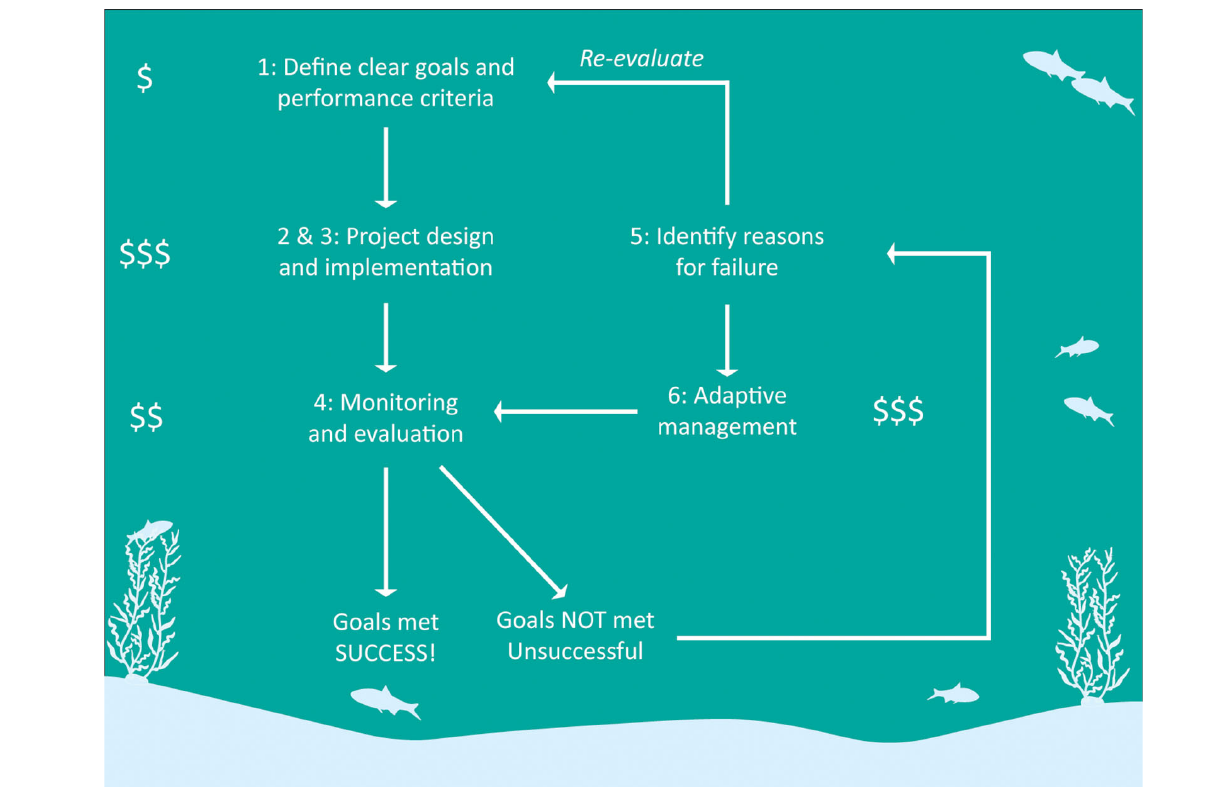
FIGURE 1 | Flow chart of best-practice steps involved in restoration projects. Dollar signs indicate the relative costs of each